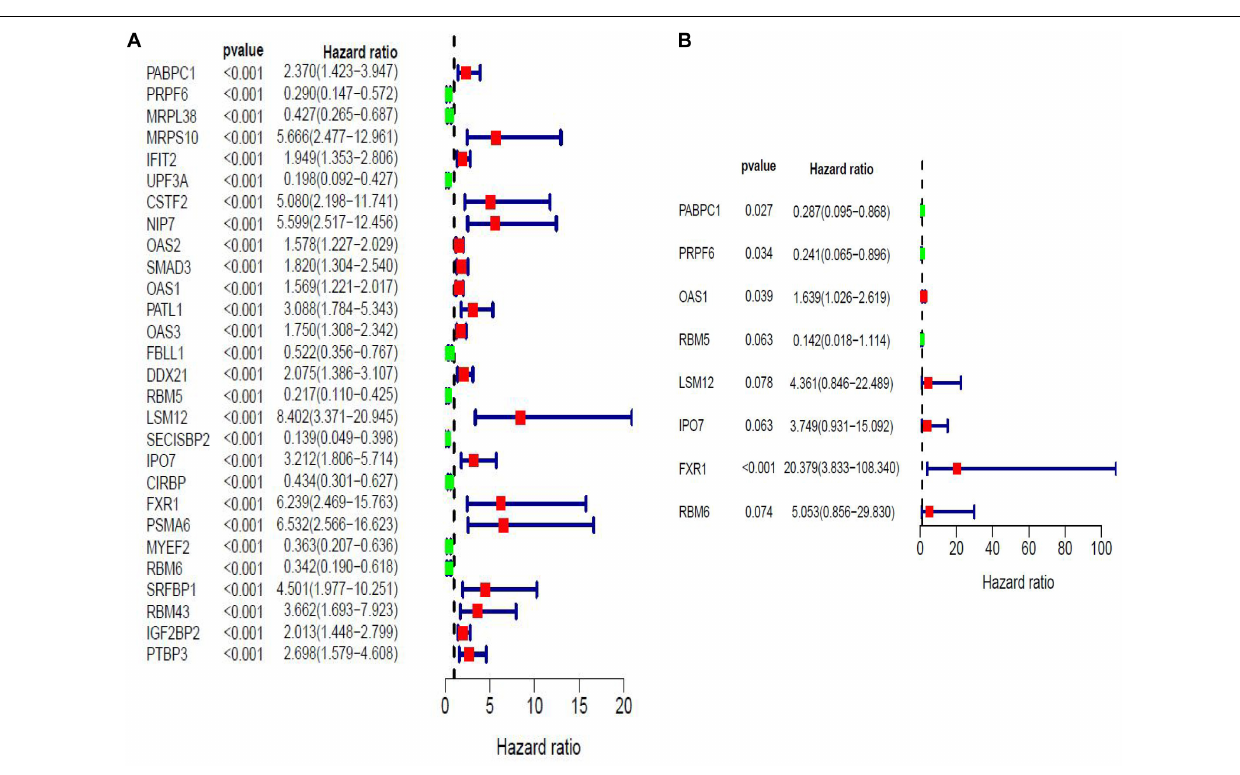
FIGURE 5 | Forest maps of prognosis-related RBPs (pRBPs) in PAAD by univariate (A) and multivariate (B) Cox regression analysis. Green boxes, lower risk RBPs with hazard ratio (HR) < 1; red boxes, higher risk RBPs with HR > 1. TABLE 3 | RNA-binding proteins (RBPs) selected to construct prognostic risk model by multivariate Cox regression analysis in modeling cohort. RBPs Coef HR 95% CI p